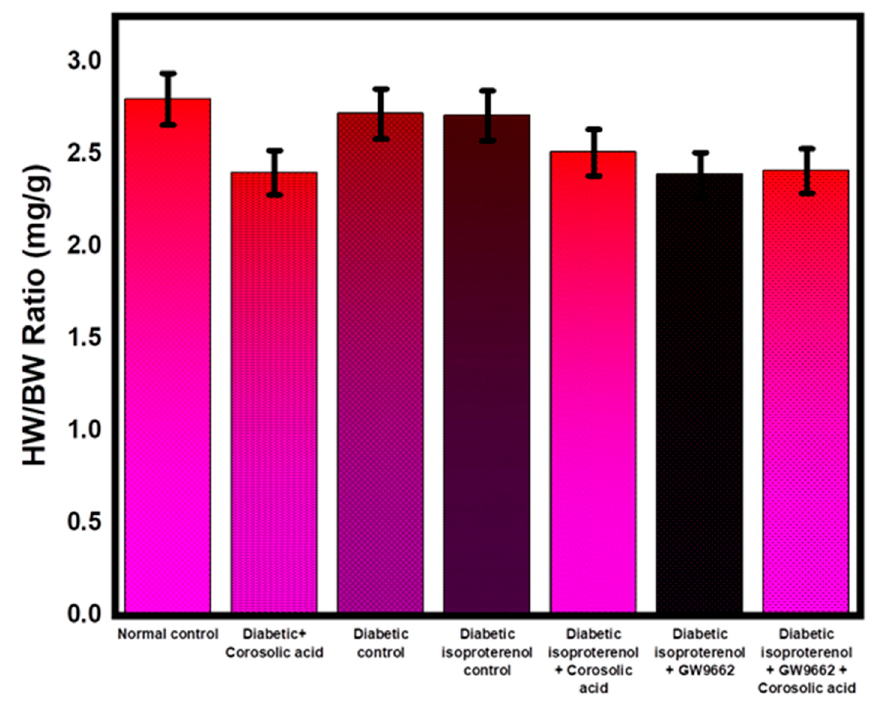
Table 1. Effect of corosolic acid on weights in different experimental groups.